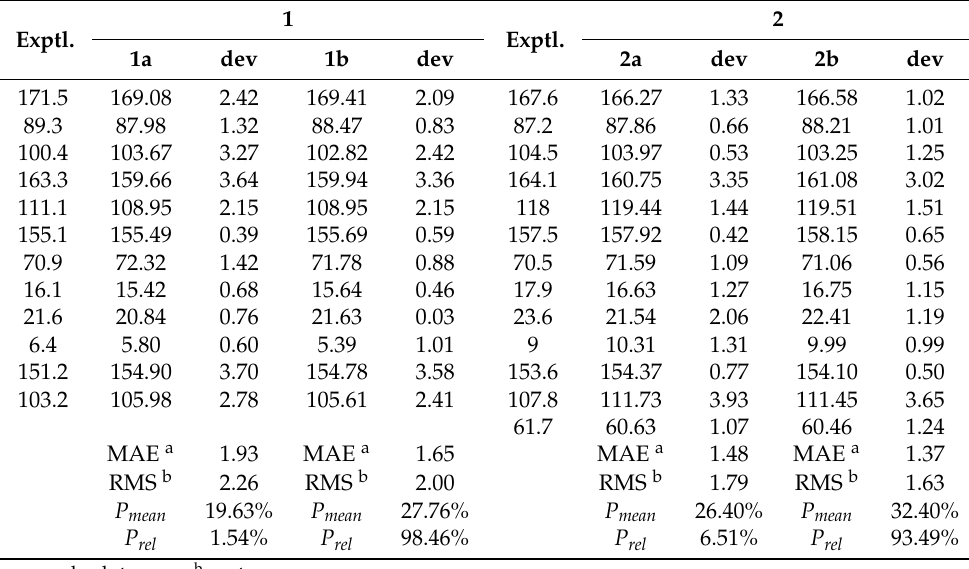
Figure 3. Regression analysis of experimental and calculated 13 C NMR chemical shifts for 1 and 2 .